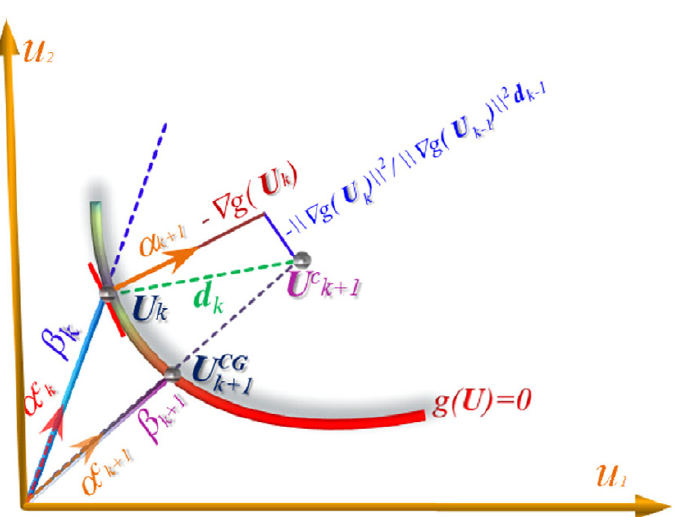
Figure 4. Schematic iterative procedure of FORM-based conjugate search direction. See [25] for more details. Reprinted with permission from [25]. Copyright 2020, Elsevier.